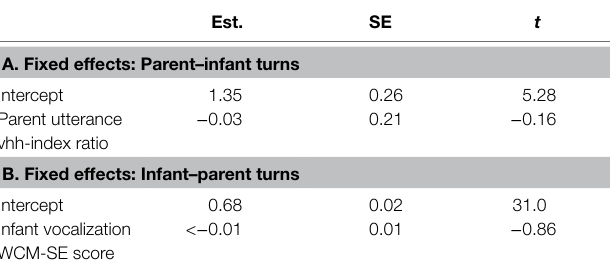
TABLE 7 | Summary of the fixed effects of the analysis of the measure vhh-index ratio in parent–infant turns (A) and infant–parent turns (B). No significant effects were found.